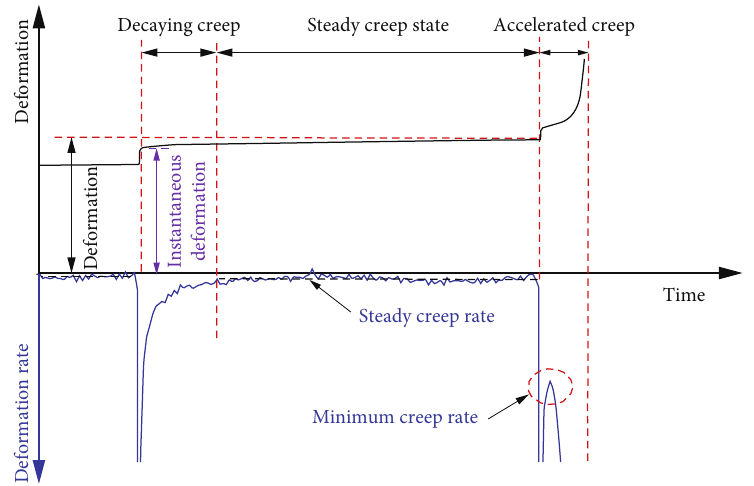
Figure 5: Basic principles of the multistage loading creep test